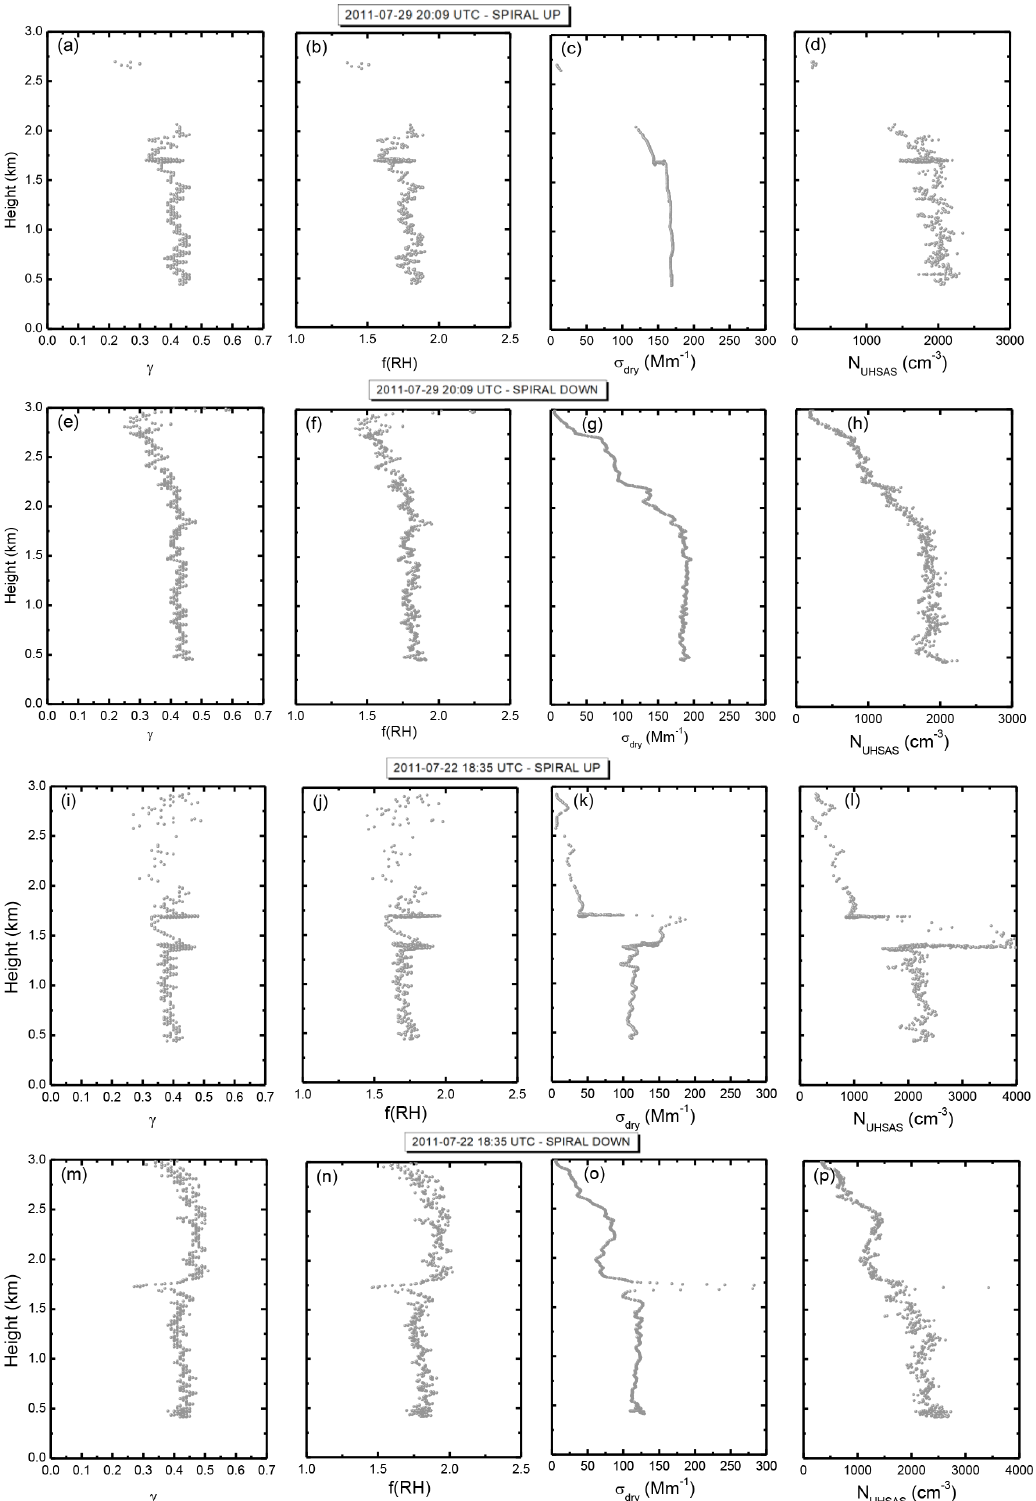
Figure 7. Vertical profiles of hygroscopicity parameter γ and f (RH), scattering coefficient at dry conditions ( σ dry ) and number of particles from UHSAS ( N UHSAS ) acquired from the P-3B airplane over the GSFC/HUBC region on the (a) 29 July spiral down, (b) 29 July spiral up, (c) 22 July spiral down and (d) 22 July spiral